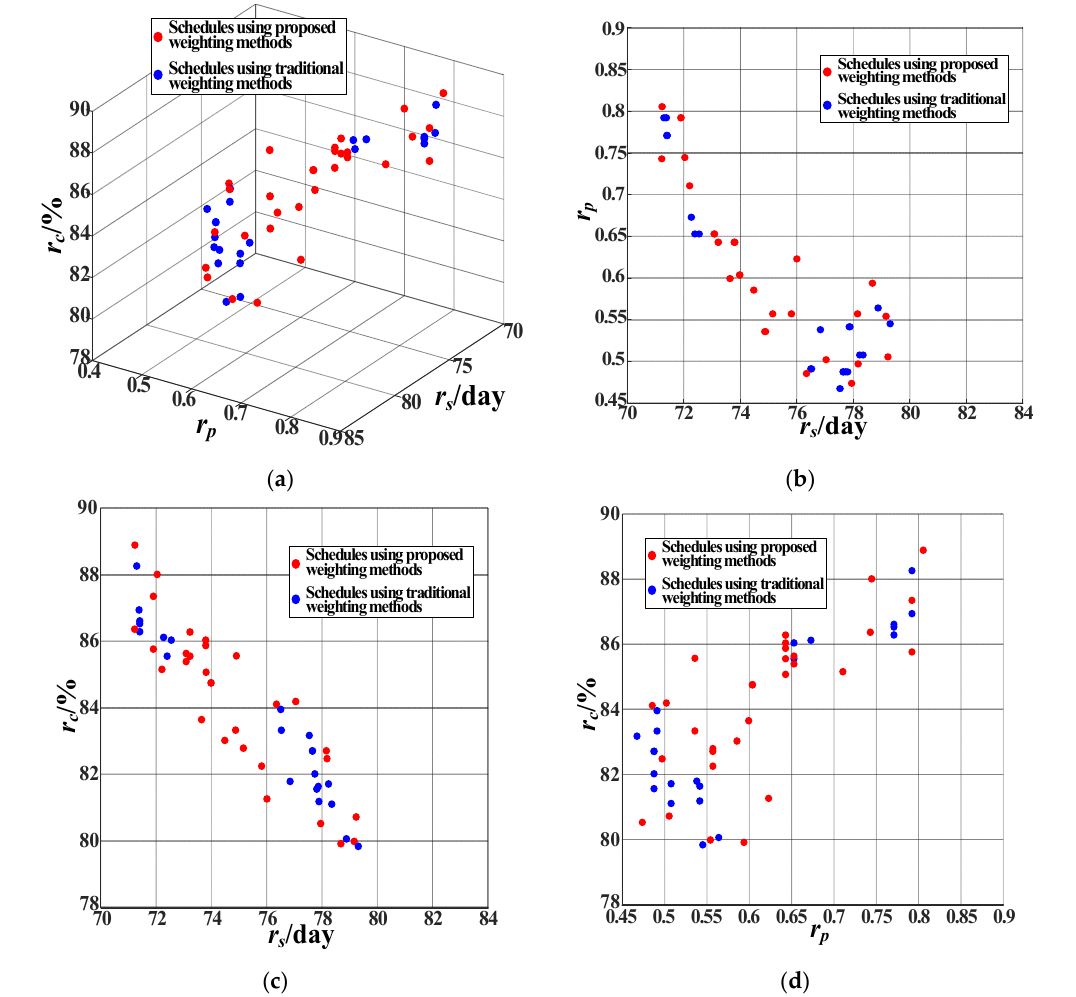
Figure 12. The optimized schedules with the objectives of T - r using two sets of weighting methods: ( a ) r s , r p , and r c of the optimized schedules; ( b ) r s and r p of the optimized schedules; (c) r s , and r c of the optimized schedules; ( d ) r p and r c of the optimized schedules.